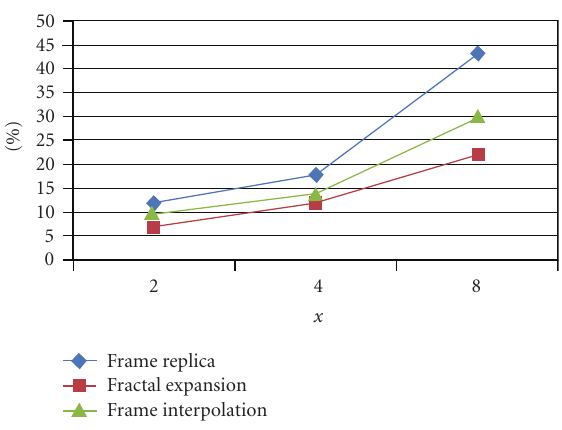
Figure 11: Measured error blocks for CrowdRun sequence.